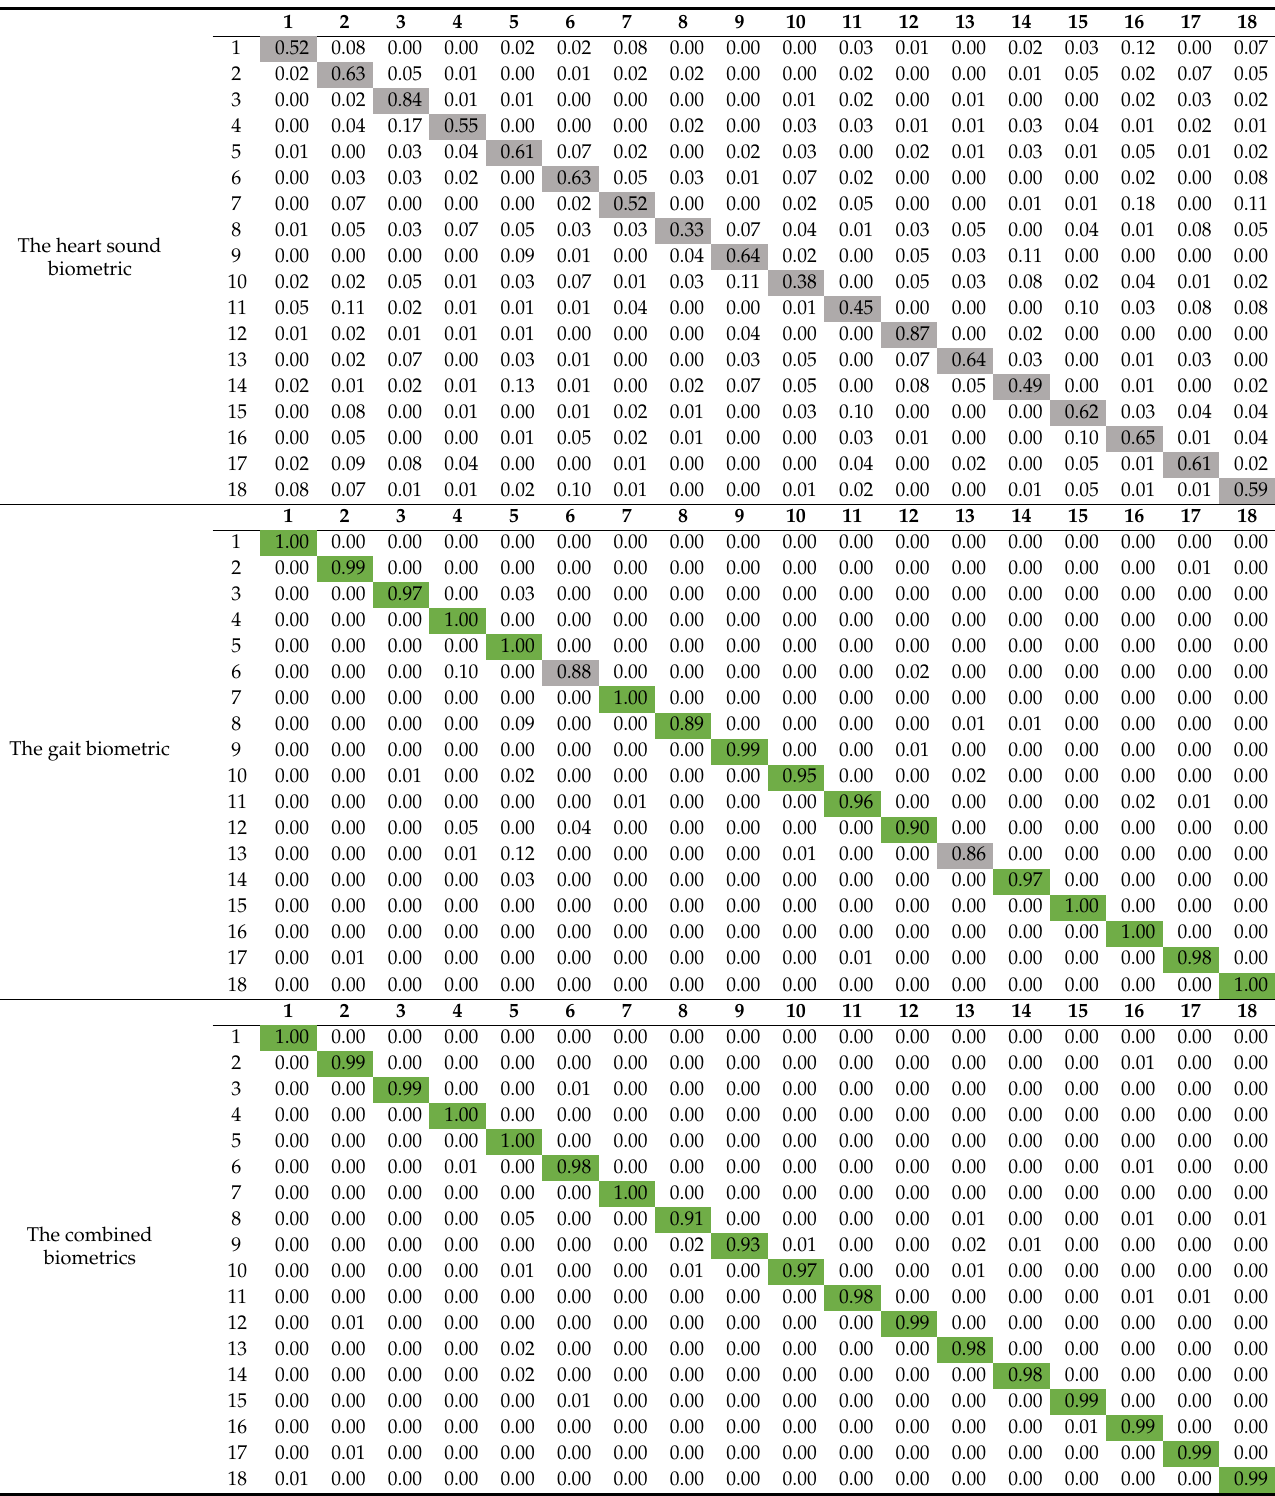
Table 5. The confusion matrices for heart sound and gait biometrics showing true classes (rows) versus predicted classes (columns) for 18 subjects (also known as classes). 1 indicates 100% of the samples in the corresponding class were predicted correctly, while 0 indicates no correct predictions. Classes are marked in green if the prediction accuracy is 90% or